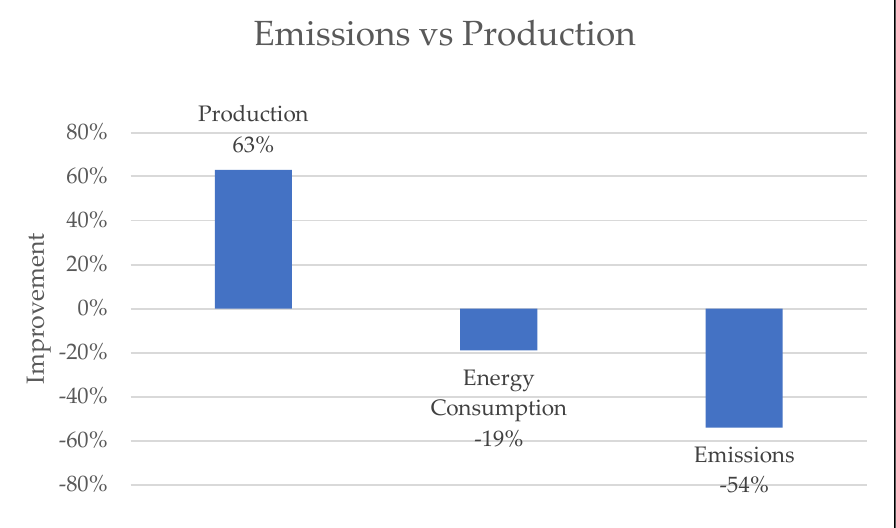
Figure 7. Development in the German chemical/pharmaceutical industry (1990–2019) [114].